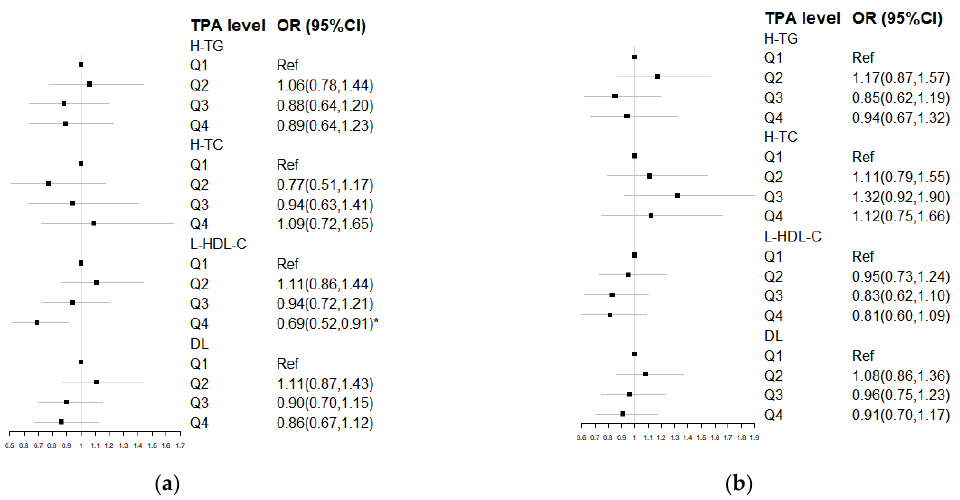
Figure 4. Odds ratios (95% CI) for dyslipidemia by quartiles of total physical activity among Chinese adults from nine provinces. All models used three-level logistic regression adjusted for survey round, baseline age, energy intake, energy from dietary fat, dietary cholesterol, BMI, waist circumference, current smoker, alcohol consumer, education, per capita household income, sedentary activity time, and urbanization index. TPA, total physical activity; H-TG, hypertriglyceridemia; H-TC, hypercholesterolemia; L-HDL-C, low high-density lipoprotein cholesterol; DL, dyslipidemia. Q = quartile. Ref, reference. * p < 0.05. ( a ) Male; ( b ) Female. Table 3. Regression coefficients (95% CI) for serum lipids on the four subtypes of physical activity in Chinese adults from nine provinces, CHNS